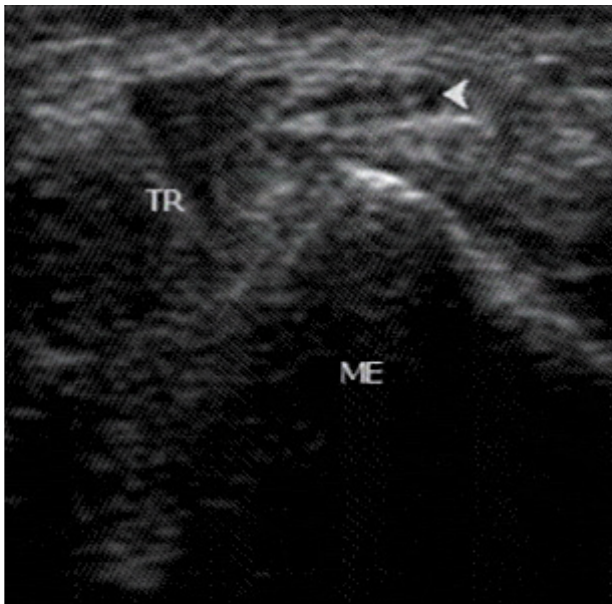
Fig. 3. The symptomatic left elbow at the level of the cubital tunnel in mid- flexion. The ulnar nerve (arrowhead) has moved over the medial epicondyle (ME). Note the flattening of the contour of the ulnar nerve. In addition, the medial head of the triceps (TR) has moved towards the medial epicondyle.